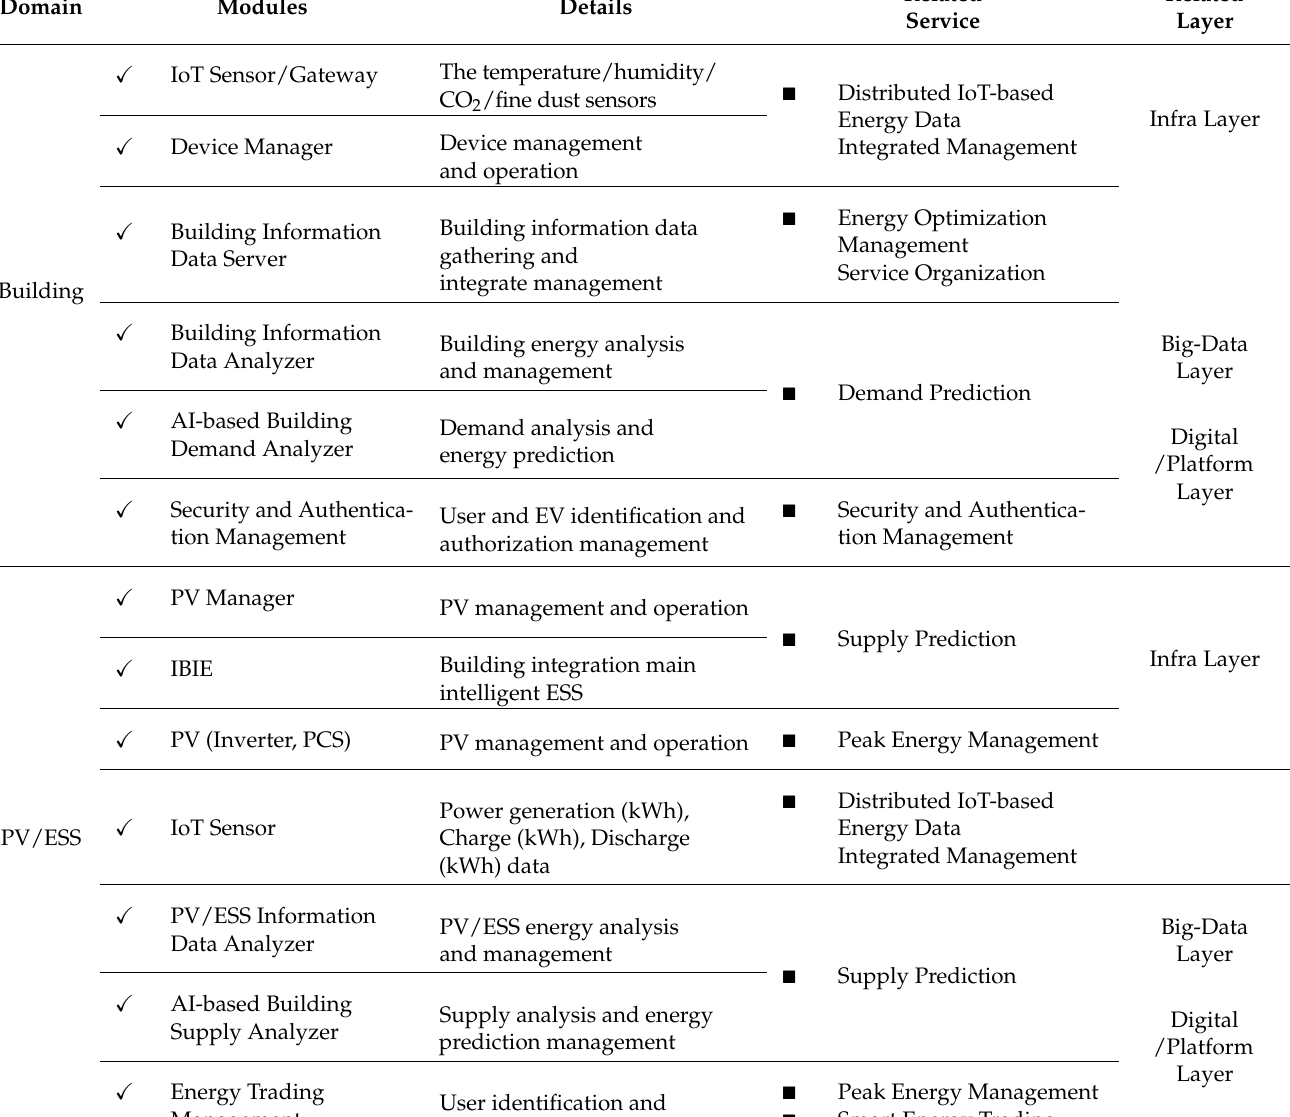
Table 2. Details of the Proposed System